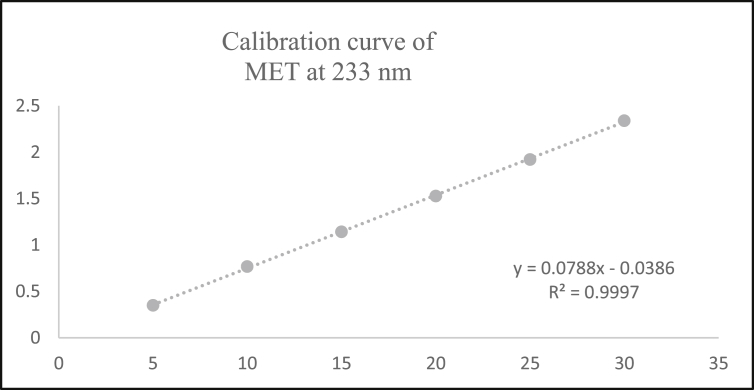
Calibration curve of MET at λ2 = 233 nm.